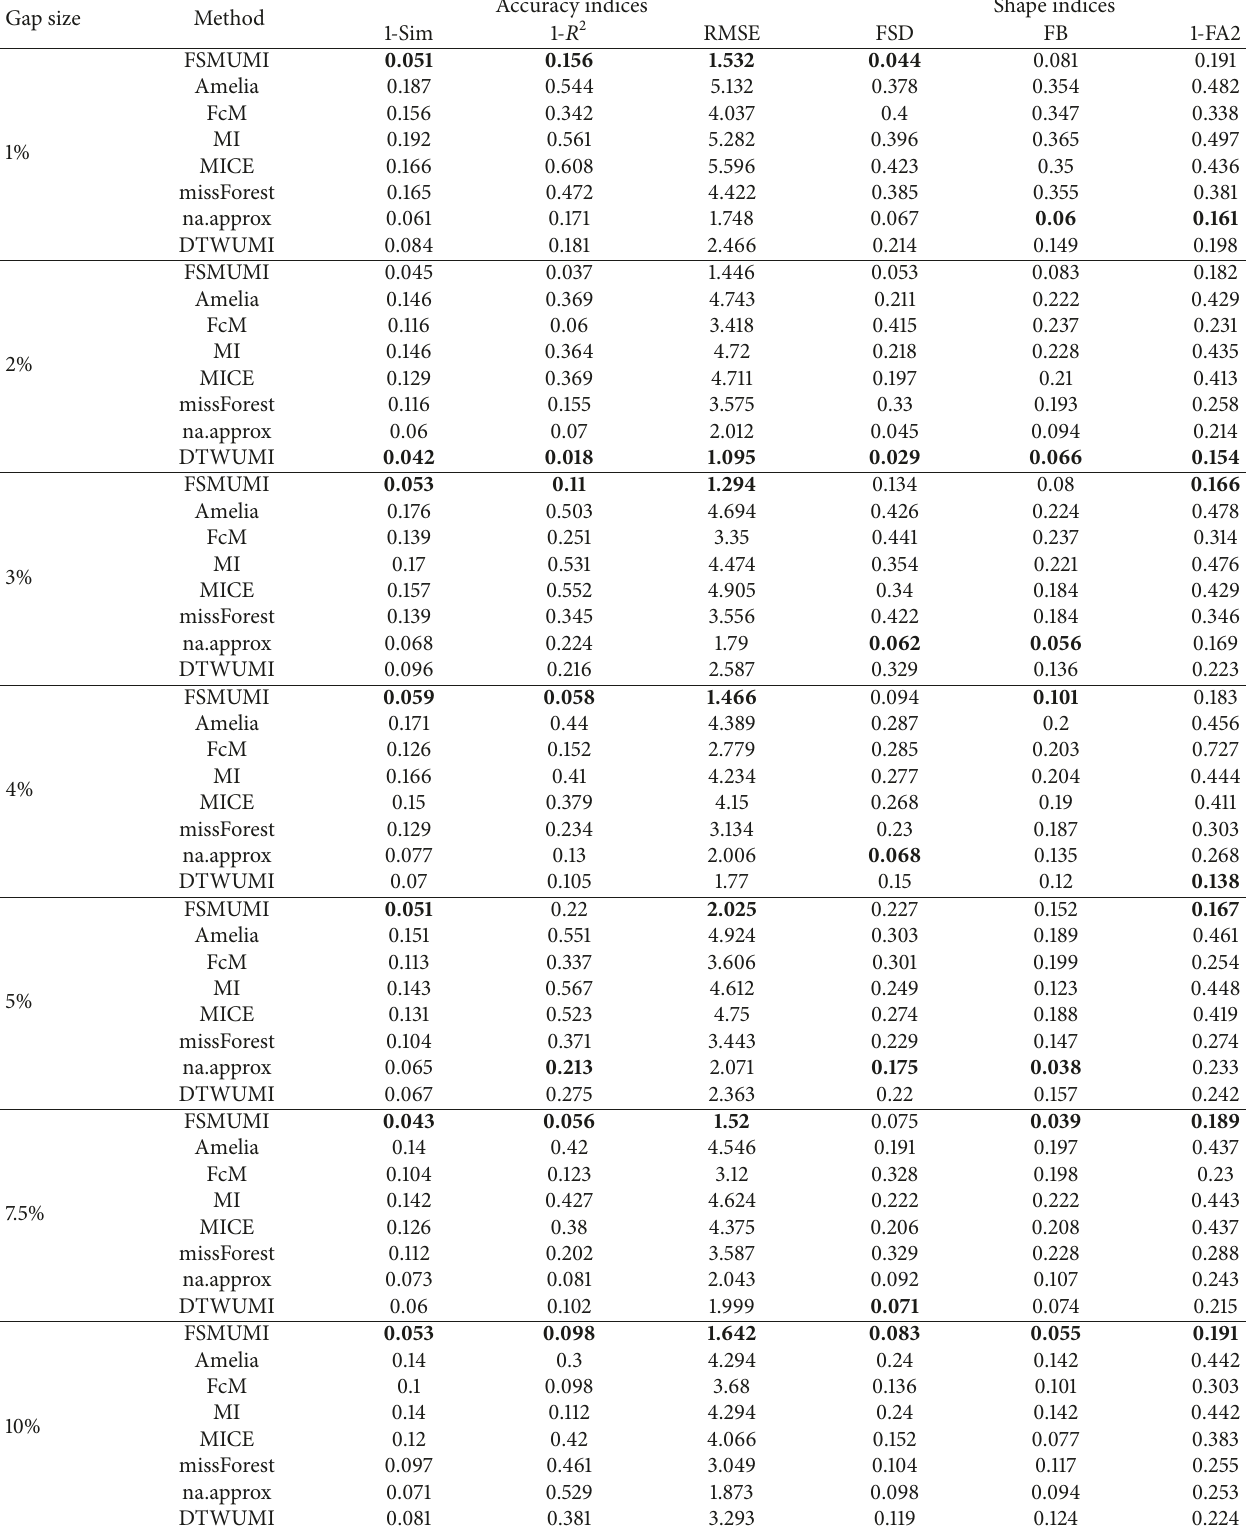
Table 3: Average imputation performance indices of various imputation algorithms on MAREL-Carnot dataset (35,334 collected points). Gap